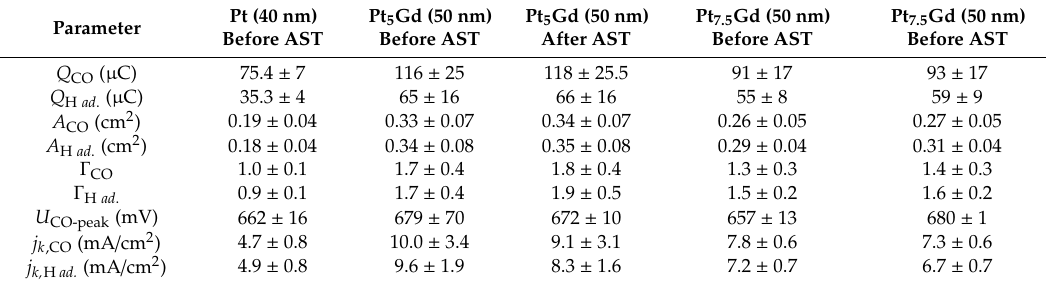
Table 2. Electrochemical data for the 40 nm Pt as-prepared and 50 nm Pt 5 Gd and Pt 7.5 Gd thin films before and after AST. Specific activities were evaluated at 0.9 V vs. RHE and are shown both using the area derived from CO oxidation and hydrogen adsorption